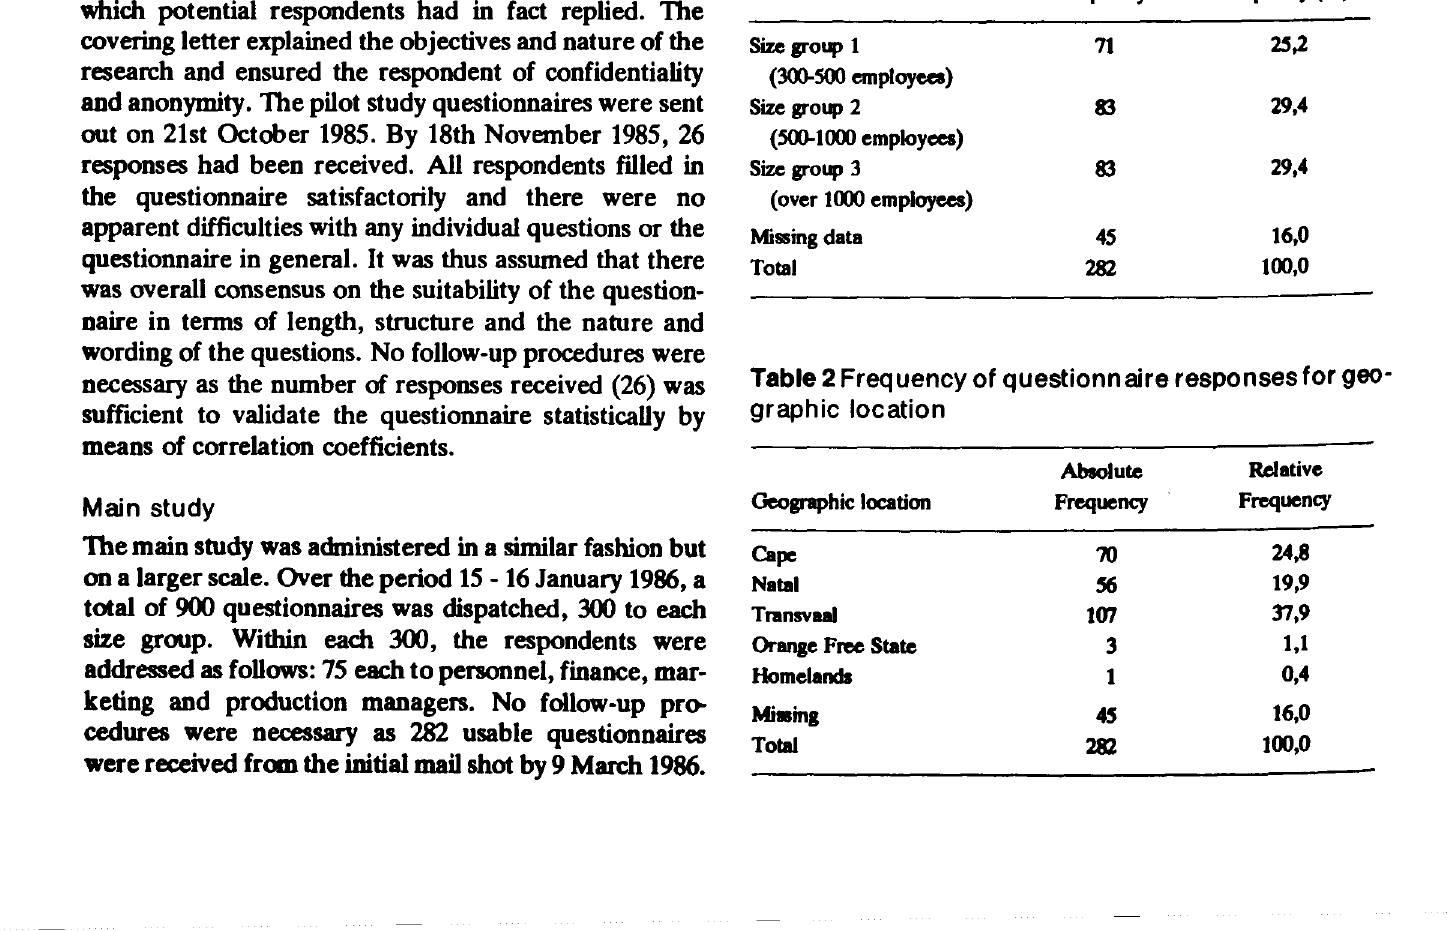
Table 1 Frequency of questionnaire responses for size